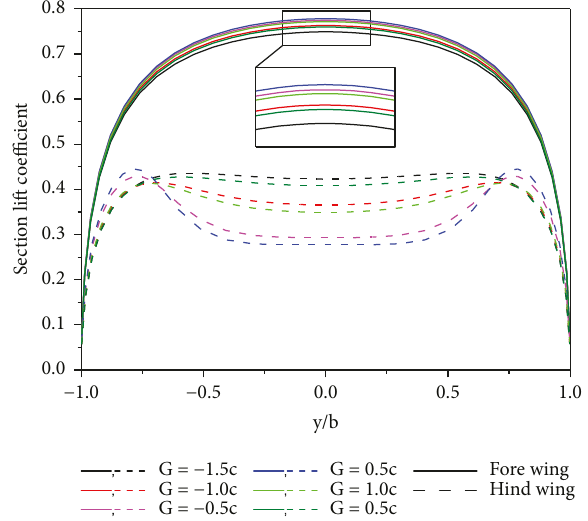
Figure 14: E ff ect of gap on section lift coe ffi cient for tandem wing con fi guration.